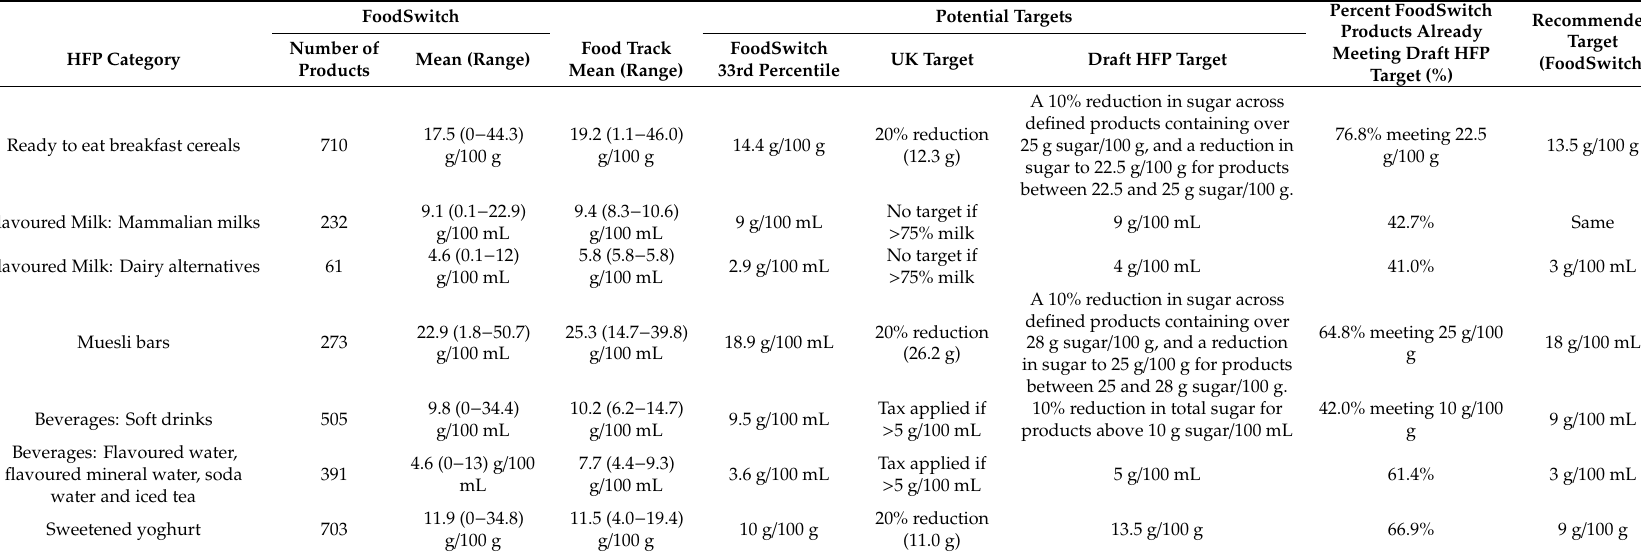
Table 3. Sugar levels of products included the FoodSwitch and FoodTrack databases, potential reformulation targets, and recommended targets based on FoodSwitch